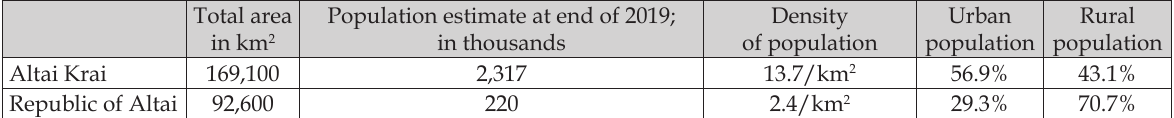
Table 1. Total area and the selected population indicators in the Altai